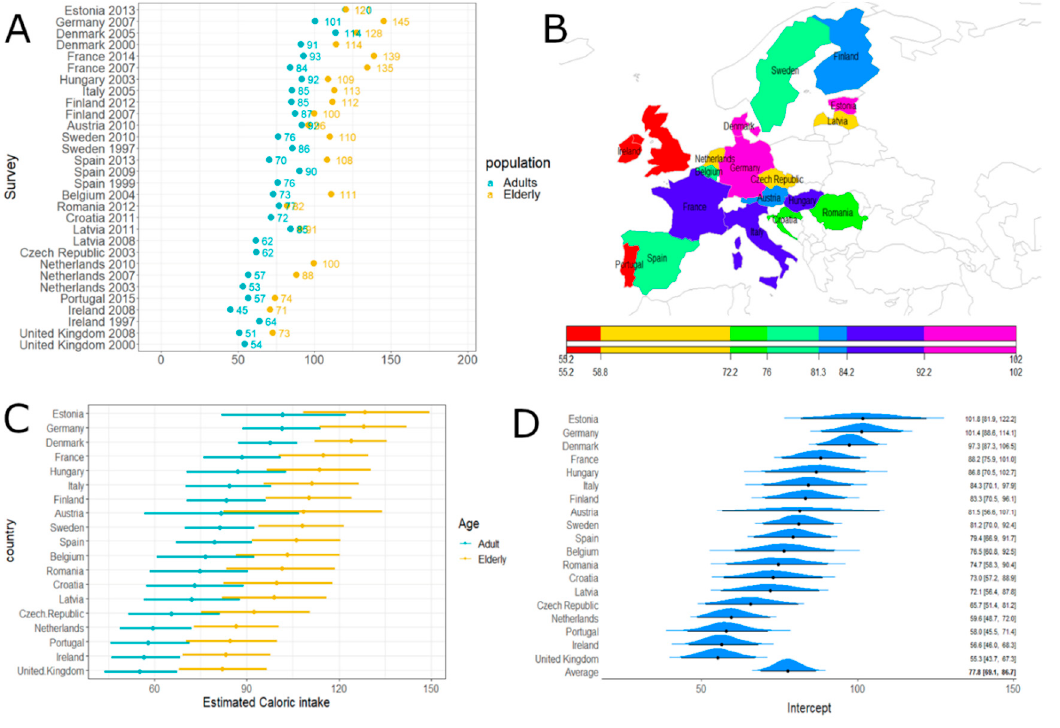
Figure 4. Fruit and fruit product caloric intake. Panel ( A ): Fruit and fruit product caloric intake (obtained by summing the means over the L7 levels) according to surveys and age classes. Panel ( B ): Estimated caloric intake across European countries. Panel ( C ): Estimated caloric intake across European countries according to age classes with 95% credibility intervals. Average effect estimate (95% CI) 77.8 [69.1; 86.73] and age effect (95% CI) 26.76 [17.45; 35.66]. Panel ( D ): Estimated caloric intake across European countries (without age effect) with 95% credibility intervals.